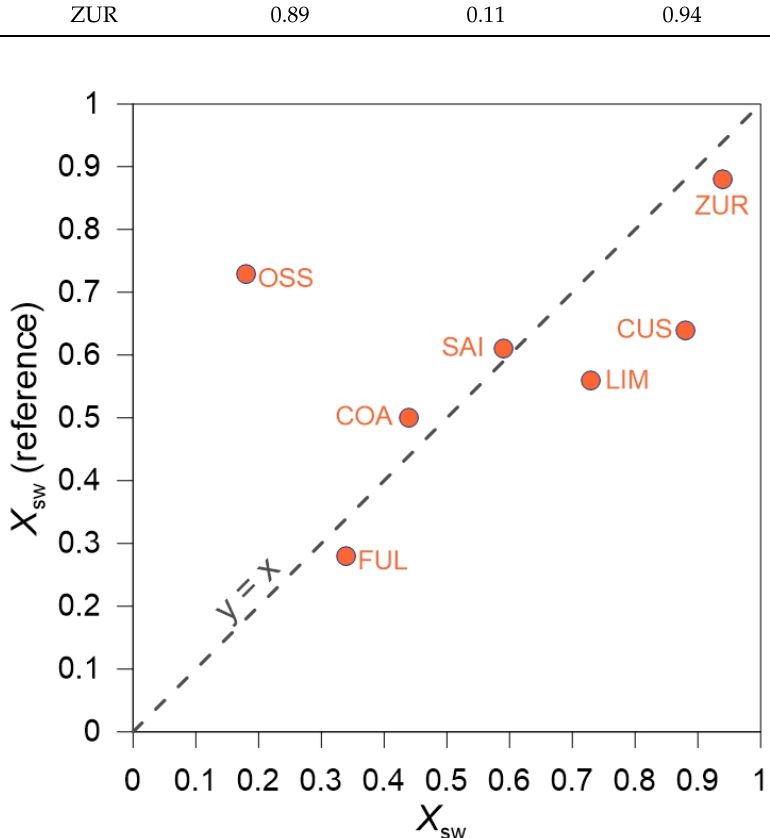
Figure 7. The fraction of seawater ( X sw ) calculated using the Cl concentration of samples taken under dynamic conditions (this study) plotted versus the fraction calculated from samples taken under static conditions [11].